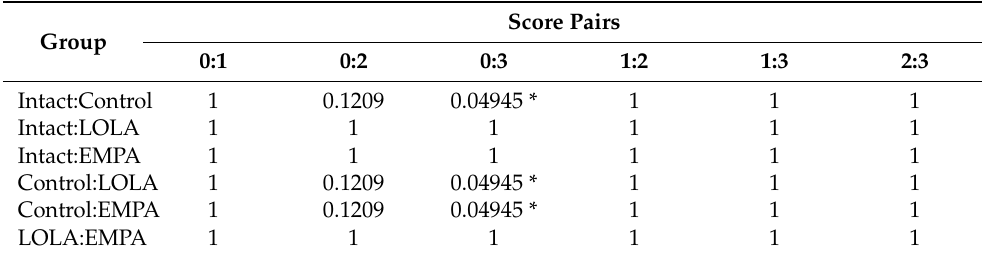
Table A4. Adjusted p -values for necrosis score frequency distributions. Group